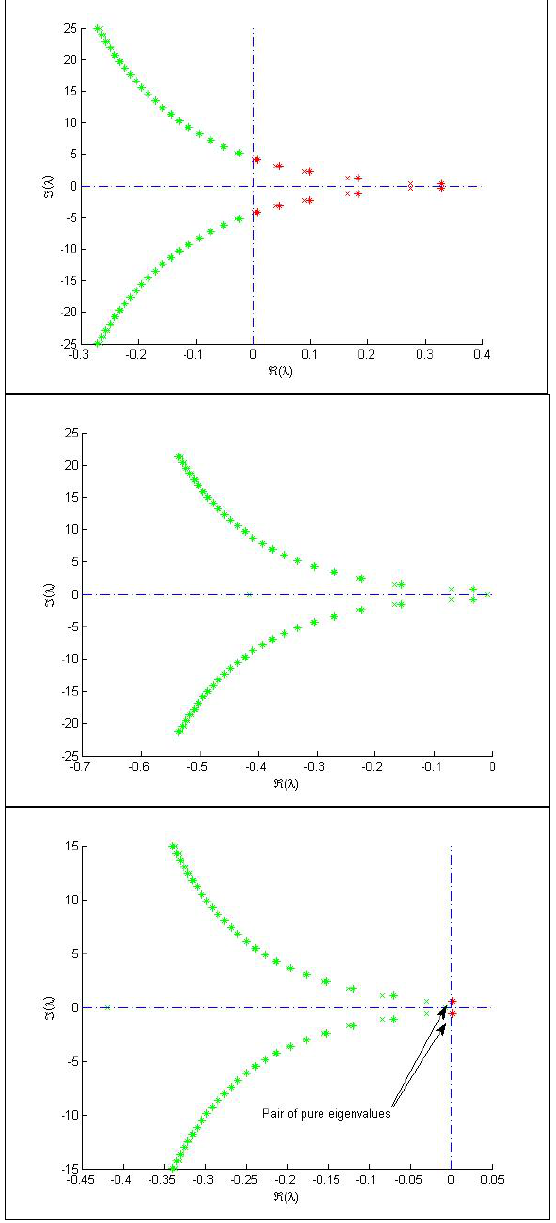
Fig. 7. The eigenvalues of the characteristic equation (38) for τ 1 = 3 (left) and τ 1 = 8 (center) with τ 2 = 0 .At τ 1 = τ (cid:48) 1 c = 6 we can clearly observe a pair of 2 pure imaginary eigenvalues (right).